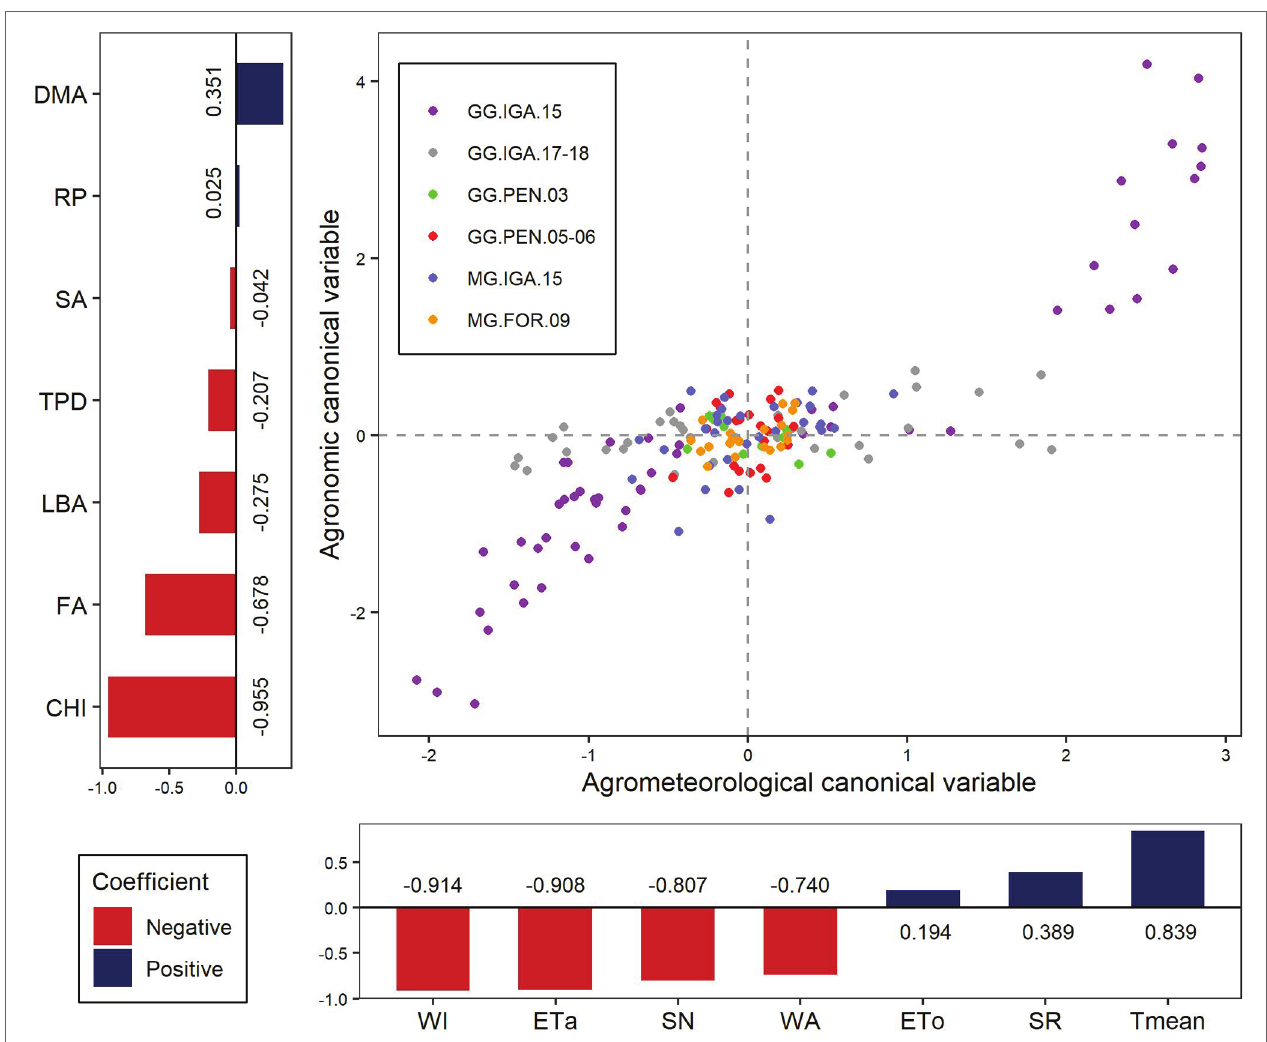
FIGURE 5 | Graphic representation of the canonical correlation between the group of agrometeorological variables (Agrometeorological canonical variable) with the agronomical variables (Agronomic canonical variable). The bar graphs to the left and below the agronomic and agrometeorological variables, respectively, represent the influence of each original variable in the generation of the canonical variable through the value of their correlation coefficient. ETa, Actual evapotranspiration; ETo, Reference evapotranspiration; SN, Supplied nitrogen; SR, Solar radiation; Tmean, Mean temperature; WA, Water applied; WI, Water index; CHI, Canopy height increment; DMA, Dead material accumulation; FA, Forage accumulation; LBA, Leaf blade accumulation; SA, Stem accumulation; and TPD, Tiller population